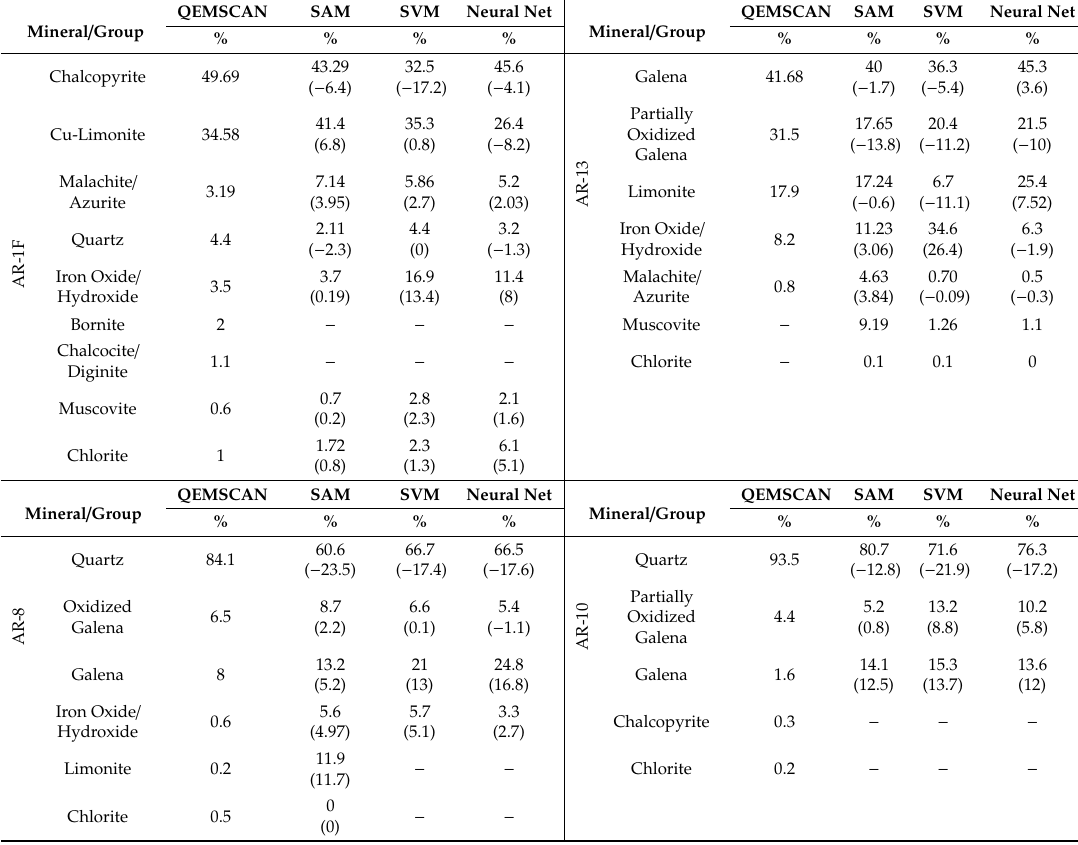
Table 2. Mineral abundances from selected sulfide samples. The number below each classified percentage in parentheses indicates the di ff erence between QEMSCAN and classification abundance. Classes with abundances that are closest to QEMSCAN proportions are